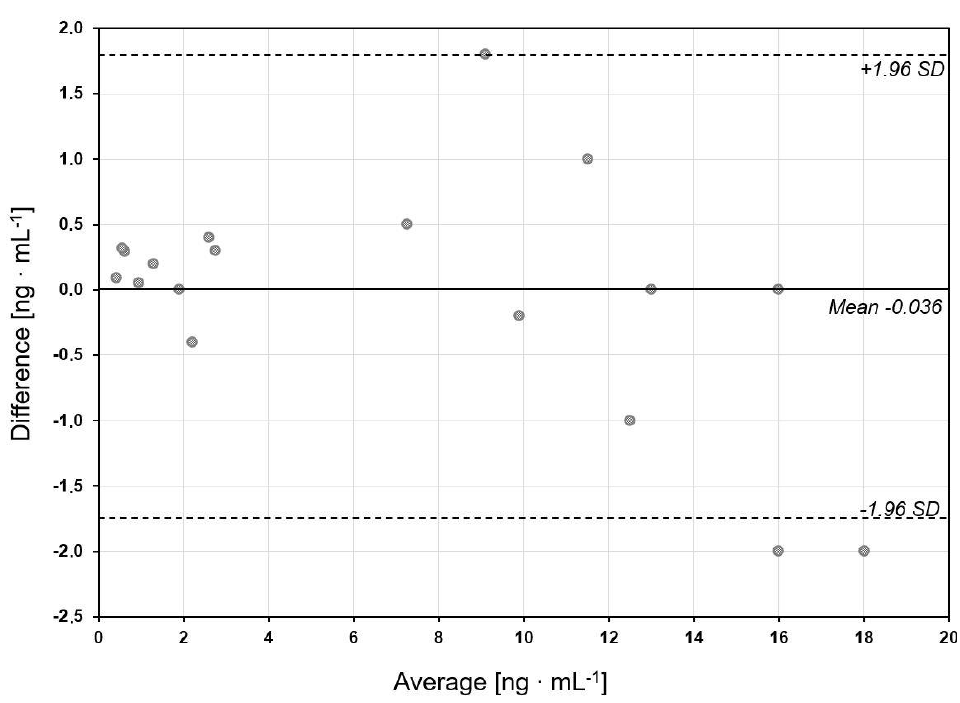
Figure 6. Bland-Altman plot for comparison of the results of cathepsin S in blood plasma as deter- mined by biosensors formed on Ag/Au and Au chips.